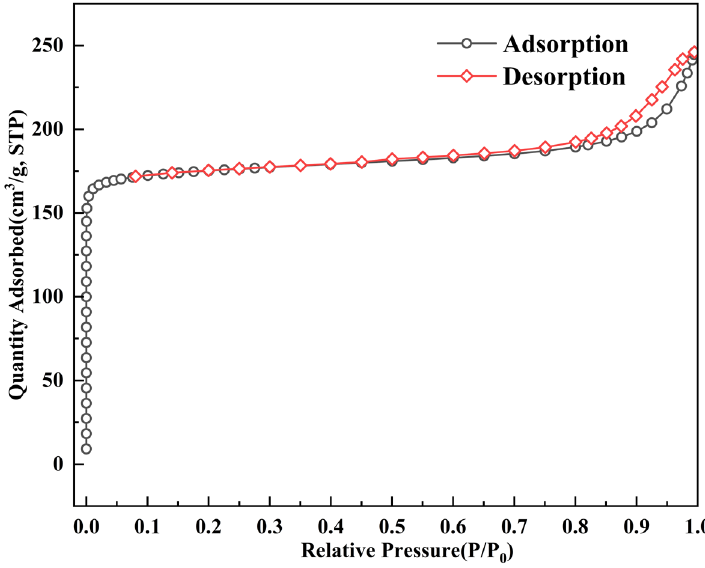
Figure 8. Nitrogen adsorption isotherm of ZC at 350 °C.